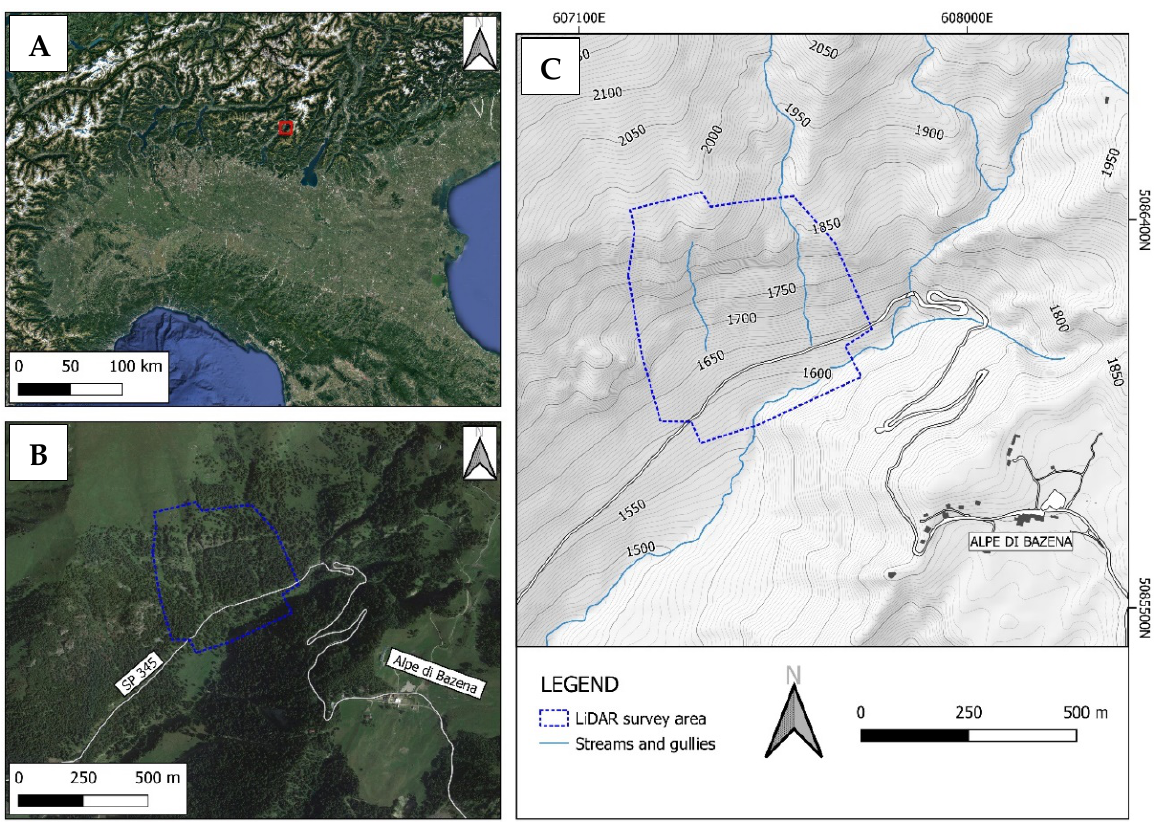
Figure 3. The case study area is in the municipality of Breno (Brescia province, Lombardia Region), in the southern portion of the Alps. The area is roughly marked by the red square ( A ), where Northern Italy is depicted; ( B , C ) describe in detail the study area.